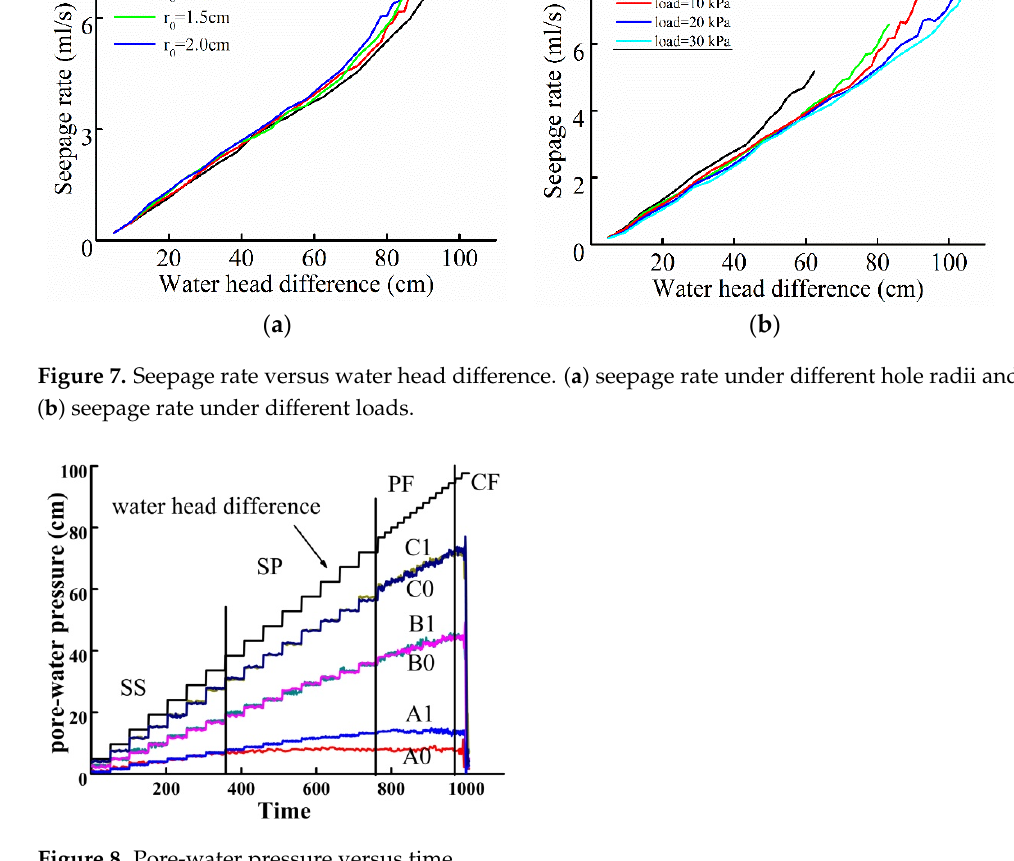
Figure 8. Pore-water pressure versus time.